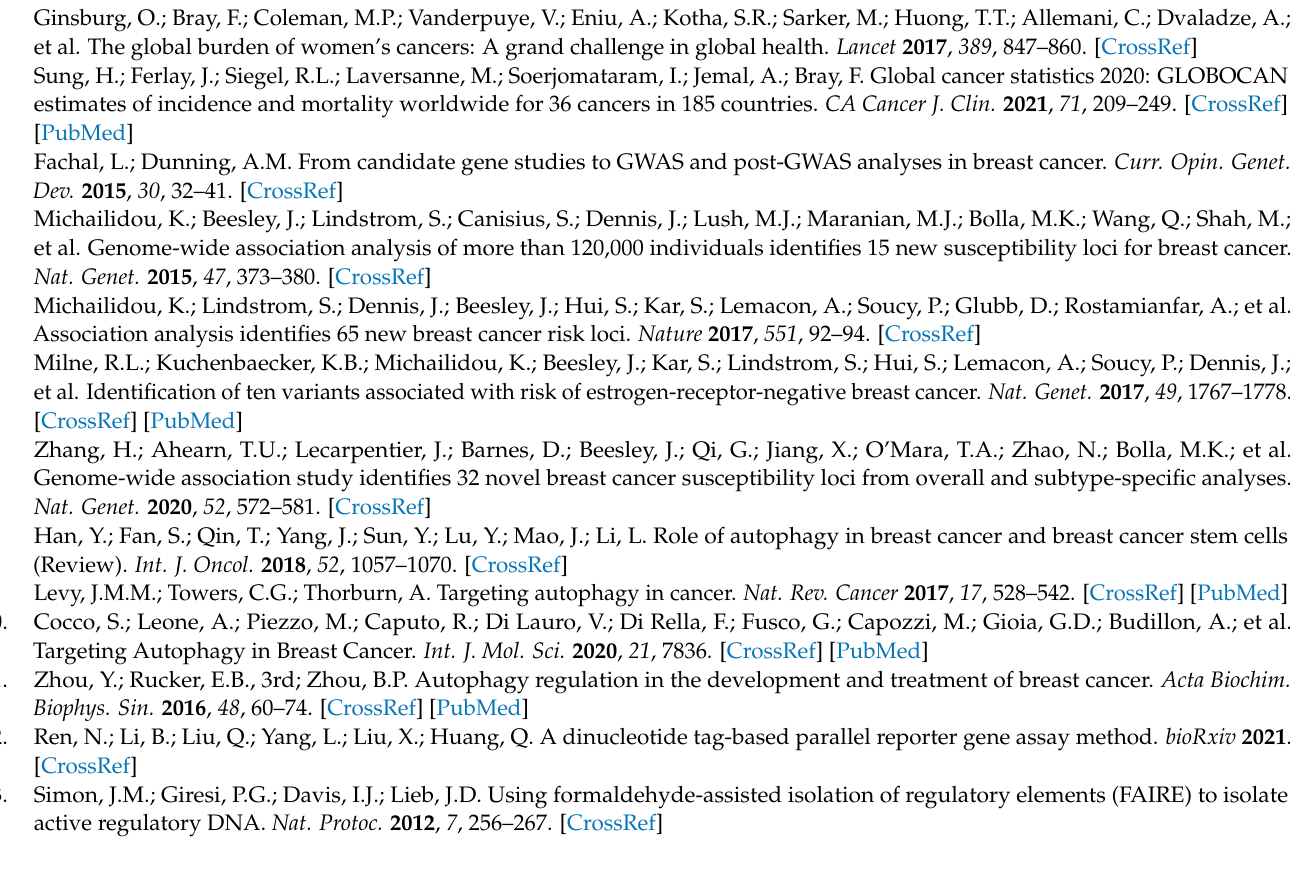
proliferation and migration. Table S1: SNP information:, Table S2: the SNP-centered DNA sequence, Table S3: qPCR